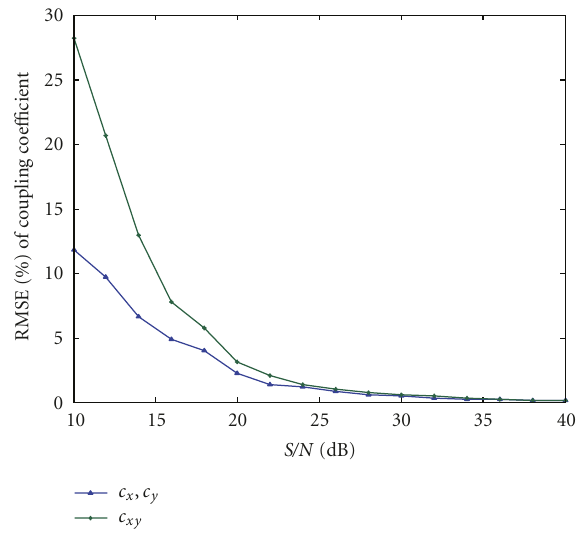
Figure 4: Recovered strength of the desired signal with the proposed algorithm in the presence of mutual coupling. Figure 5: RMSE of the coupling coe ffi cients versus the SNR.